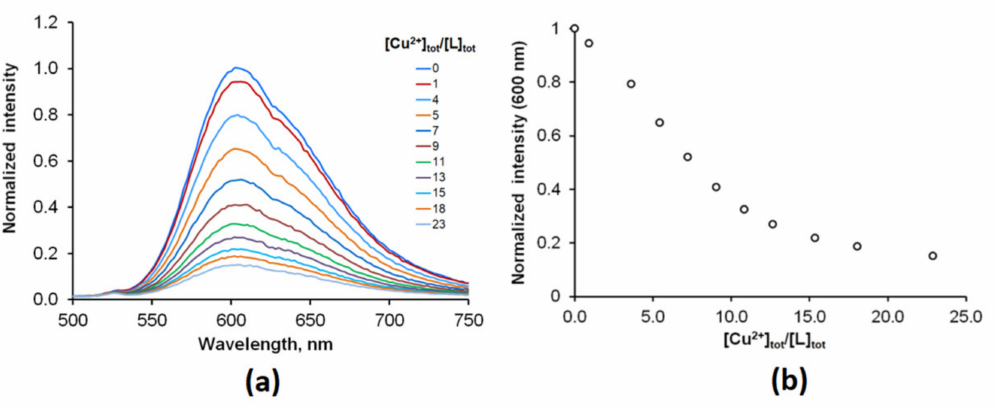
Figure 6. ( a ) Evolution of the fluorescence spectrum of the Ru(N 2 P 2 phen) solution upon addi- tion of Cu(ClO 4 ) 2 (0–23 equivalents) ([ Ru(N 2 P 2 phen) ] tot = 5.4 µ M, pH = 7.4, [HEPES] = 0.03 M, ([Cu 2+ ] tot = 0–128 µ M and λ ex = 450 nm). ( b ) Changes in the fluorescence intensity with [Cu 2+ ] tot /[ Ru(N 2 P 2 phen) ] tot ratio at λ em = 600 nm. [Cu 2+ ] tot concentrations for each point: